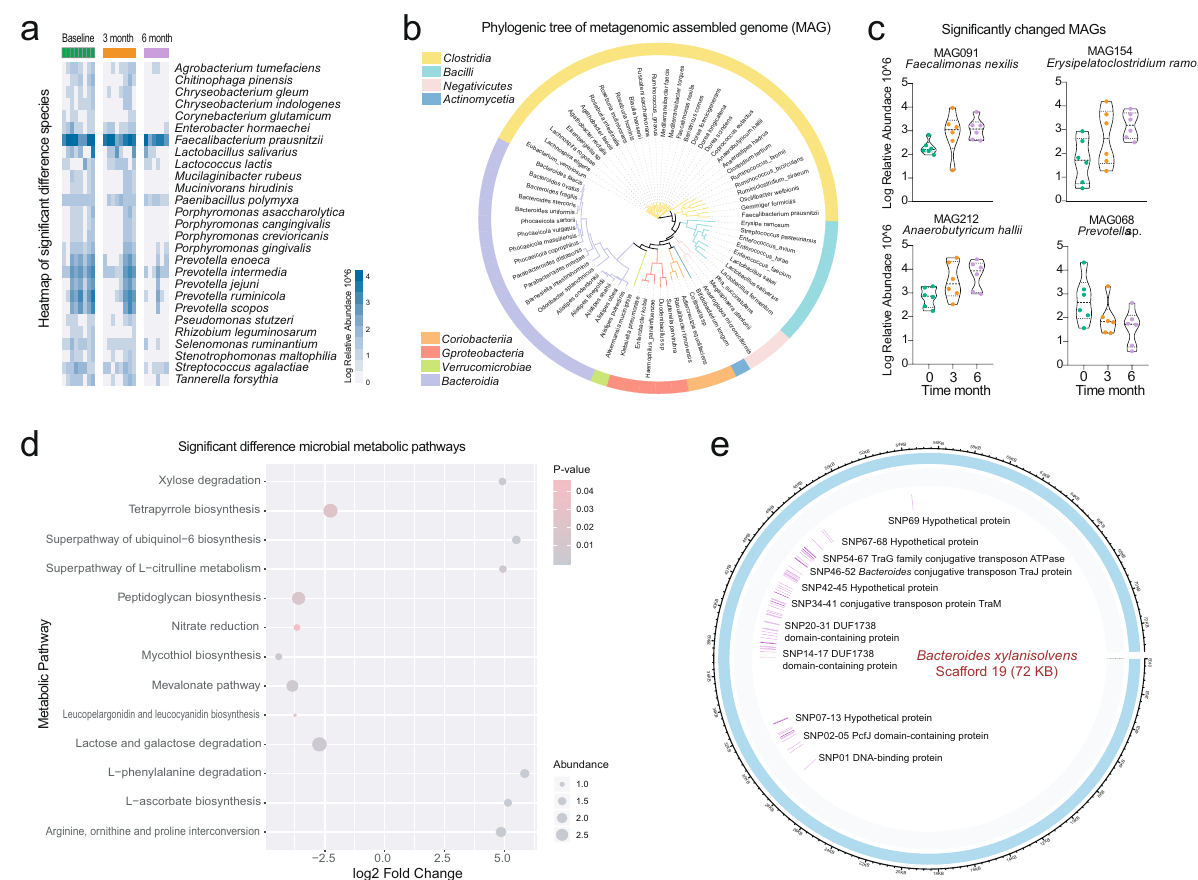
Fig. 3 The methimazole intake alerted the intestinal microbiota in the ecological and evolutionary aspect. a The signi fi cantly different metagenomic species among different time points. b Phylogenetic tree of the MAGs with clades colored by order. c MAGs of signi fi cant difference among different time points. d The intestinal microbial metabolic pathway that differed signi fi cantly between the samples at baseline and the samples with 6 months of methimazole treatment. e Genomic locations and contexts of SNPs in the species of Bacteroides xylanisolvens . These SNPs in Bacteroides xylanisolvens genome are mainly enriched in scaffold 19 and these genes related to the function of DNA-binding protein, conjugative transposon protein, and TraG family conjugative transposon